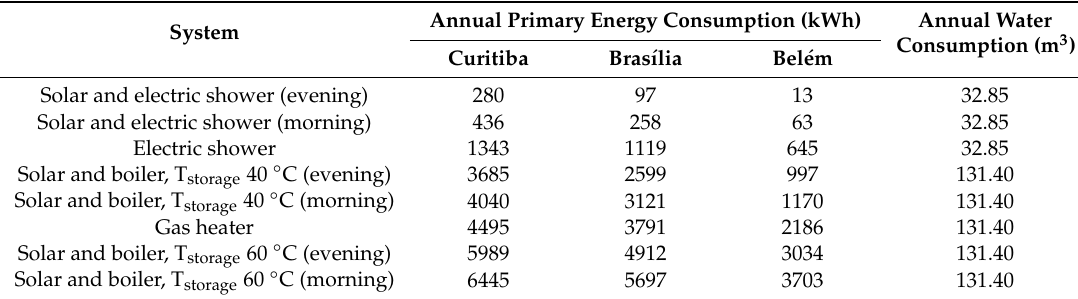
Table 8. Comparison of primary energy consumption and water